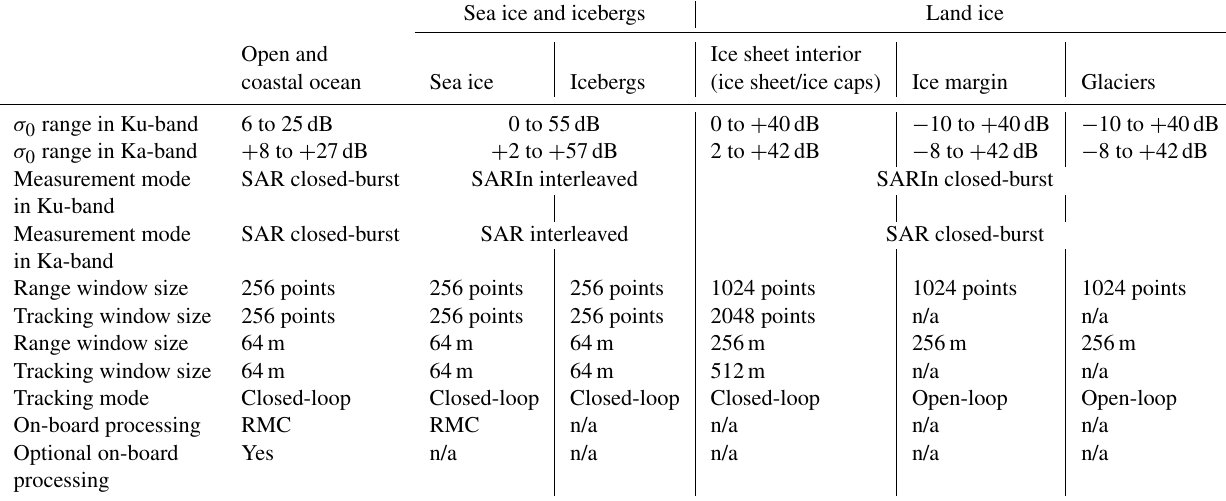
Table 3. Key altimeter characteristics in the different modes of operation (credits: Thales Alenia Space, France); n/a: not applicable. Sea ice and icebergs Land ice Open and Ice sheet interior coastal ocean Sea ice Icebergs Ice